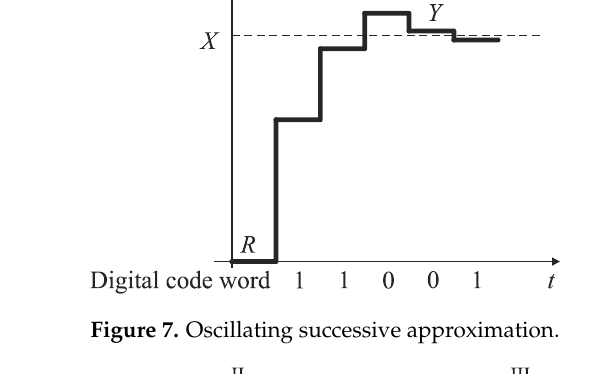
Figure 7. Oscillating successive approximation.